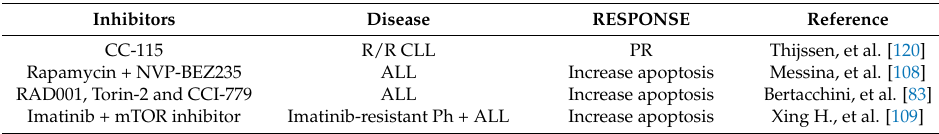
Table 2. mTOR inhibitors in lymphoid